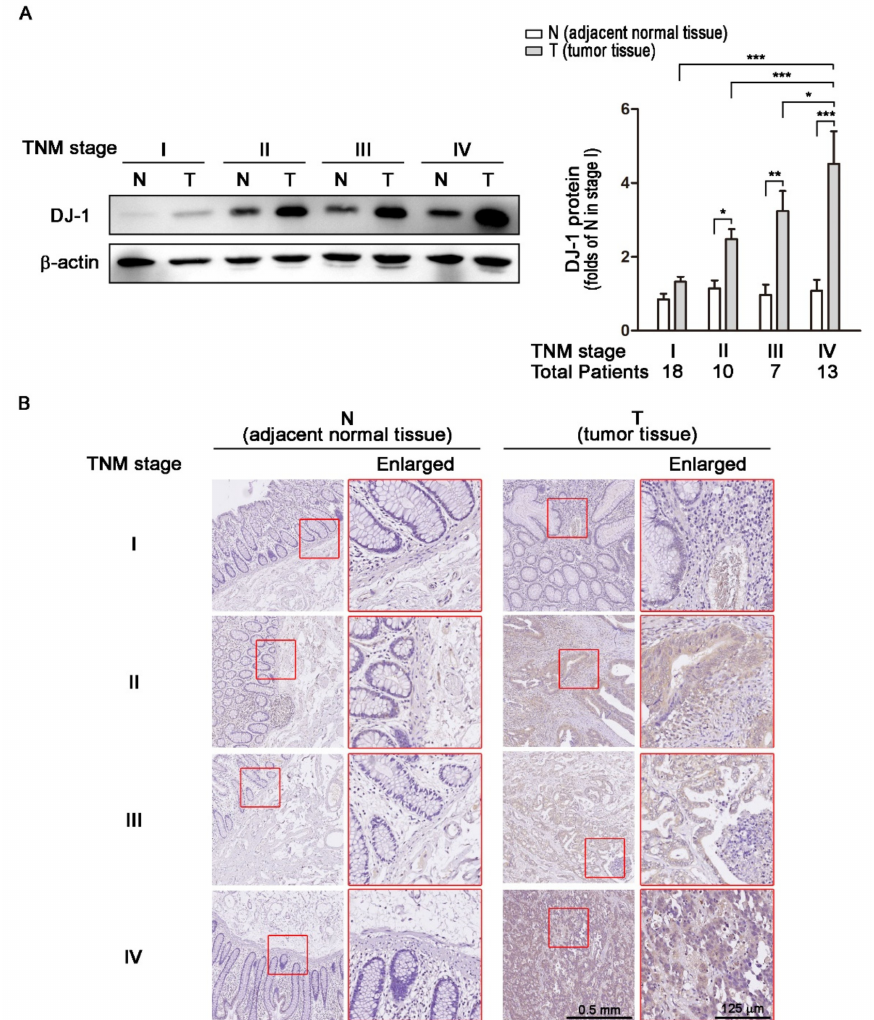
Figure 2. DJ-1 protein overexpression in tumor tissues is positively correlated with TNM stages of colorectal cancer patients. ( A ) The Western blot result of DJ-1 protein expressions in tissue pairs from 18 Taiwanese patients with TNM stage I colorectal cancer shows that DJ-1 did not significantly change between tumor tissue (T) and adjacent normal tissue (N). In the tissue pairs from TNM stage II ( n = 10), III ( n = 7), and IV ( n = 13) colorectal cancer patients, DJ-1 proteins significantly increased in T but not N. In addition, the increase of DJ-1 protein was TNM stage-dependent. The quantification data of DJ-1 protein levels are shown on the right panel. ( B ) DJ-1 immunohistochemistry (IHC) data show that DJ-1 staining increased in T but not N in Taiwanese patients with colorectal cancer that was positively correlated with TNM stages. The enlarged images on the right panels are from the respective red squares of the left panels. Our data suggest that DJ-1 protein increase in tumor tissue is positively correlated with TNM stages of colorectal cancer patients. Quantitative data are expressed as the means ± S.E.M; the p -value was determined by one-way ANOVA/Newman-Keuls test. *: p < 0.05, **: p < 0.01, ***: p < 0.001 compared with the respectively